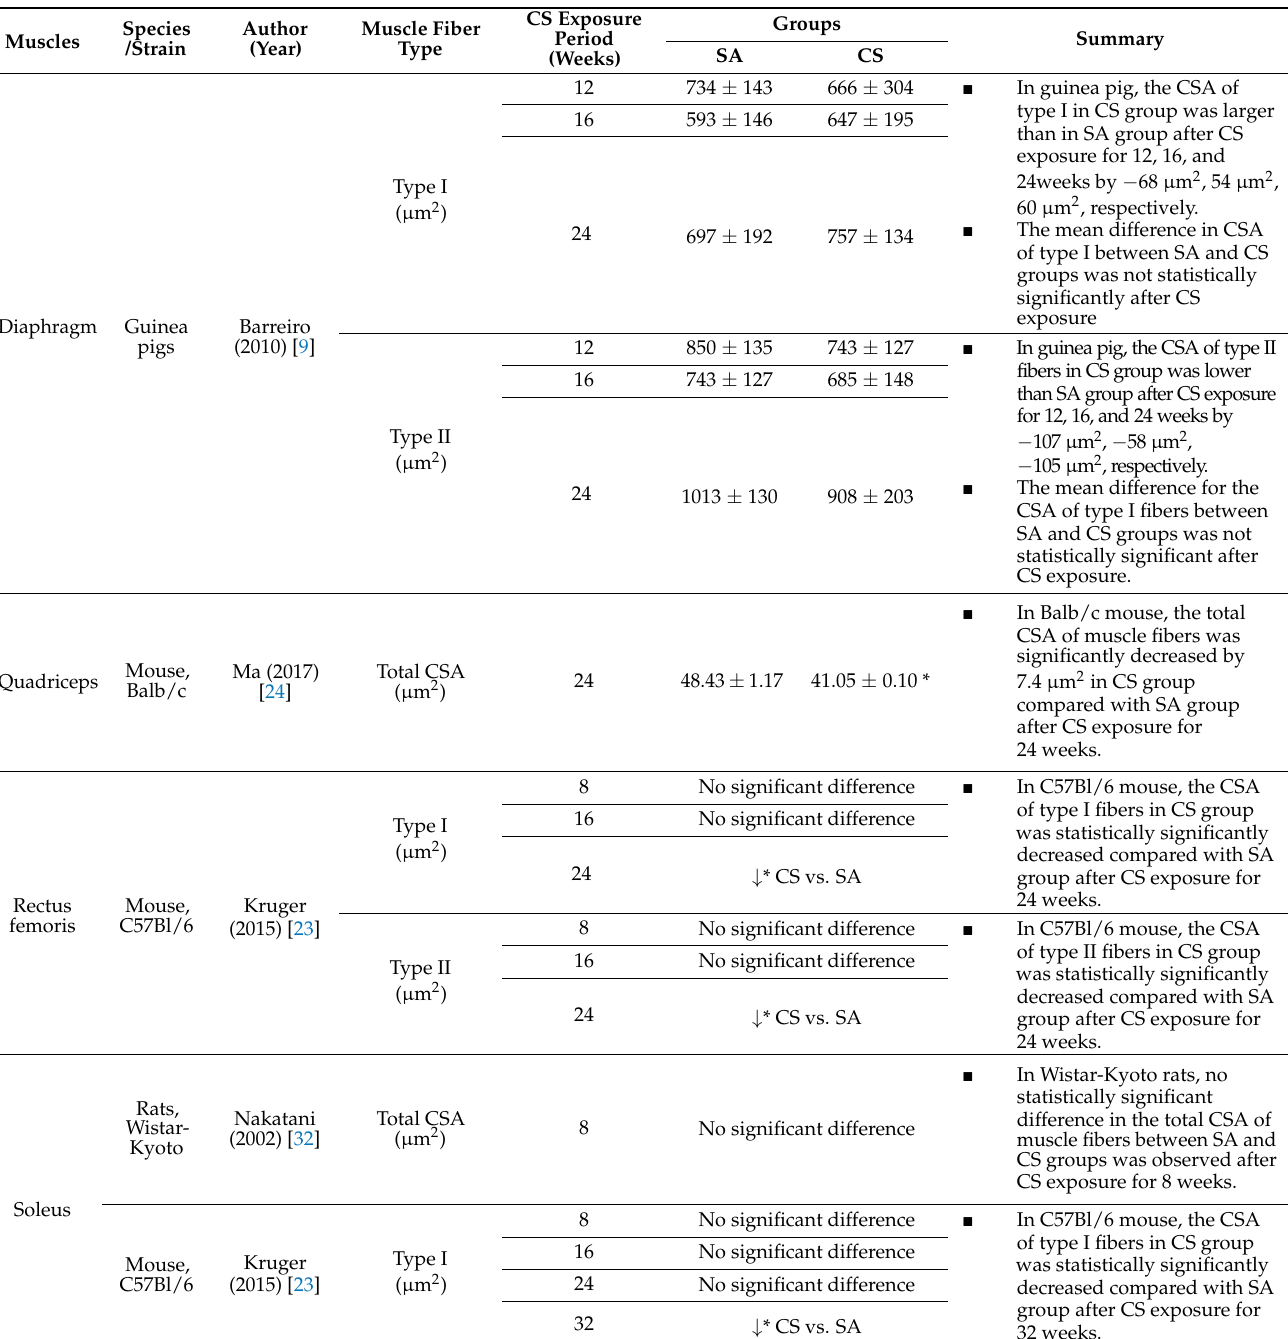
Table 5. Cross-sectional area (CSA) of muscle fibers at different time points during CS